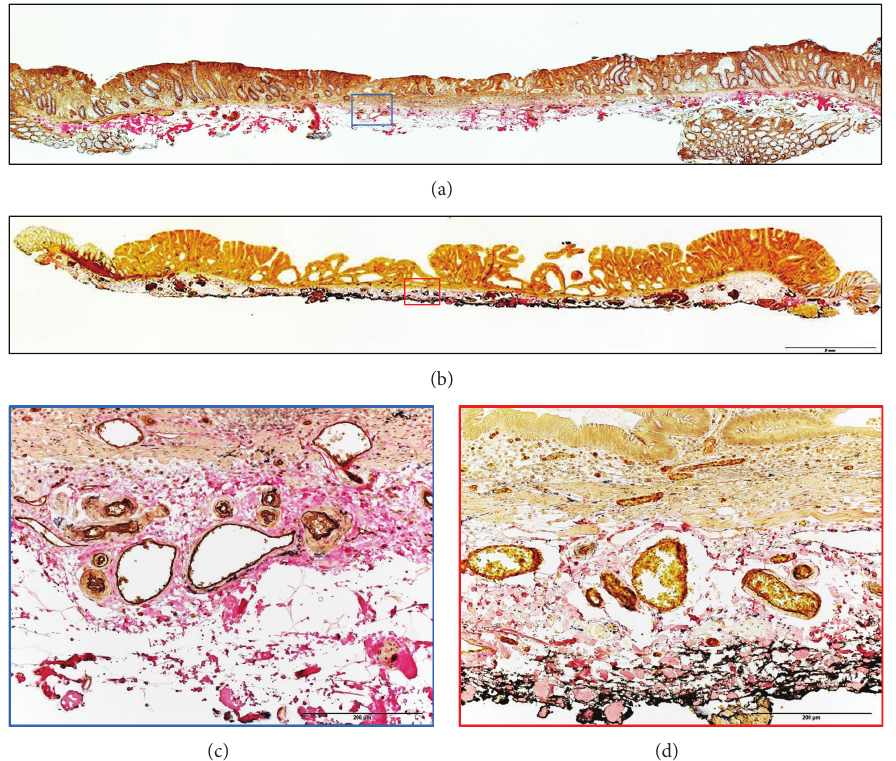
Figure 3: Estimation of submucosal vascular density of laterally spreading tumors (LSTs): all the vessels ≥ 5 𝜇 m in diameter were counted and arterioles and venules were distinguished. (a) A typical case of LST-nongranular (LST-NG) type with higher vascular density (56.3 vessels/mm 2 ) than (b) a LST-granular (LST-G) type with 31.7 vessels/mm 2 . (c) The double staining with Factor VIII + Elastica van Gieson has facilitated the identification of arterioles and venules for LST-NG and for (d) LST-G, original magnification ×